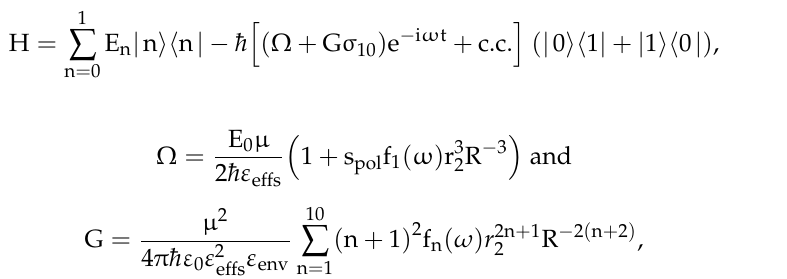
Figure 2. Energy-level configuration of the hybrid system. The two-level diagram with the ground Figure 2. Energy ‐ level configuration of the hybrid system. The two ‐ level diagram with the ground state | 0 (cid:105) and the direct exciton state | 1 (cid:105) describes the quantum emitter (SQD) and the electronic state |0 ⟩ and the direct exciton state |1 ⟩ describes the quantum emitter (SQD) and the electronic continuum states are associated with the continuum states are associated with the MNS.